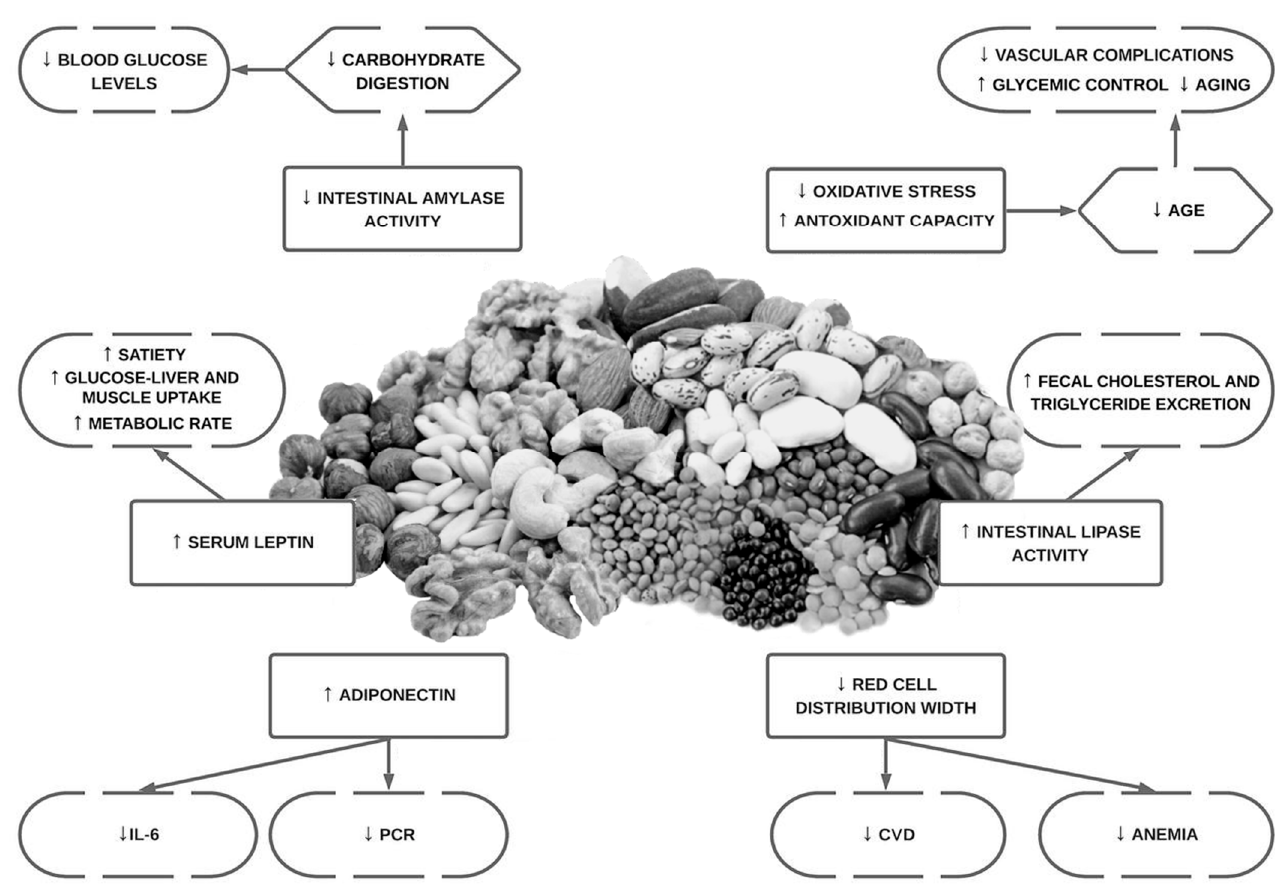
Figure 2. Overview of the potential bioactivities in cardiovascular health of phytate.